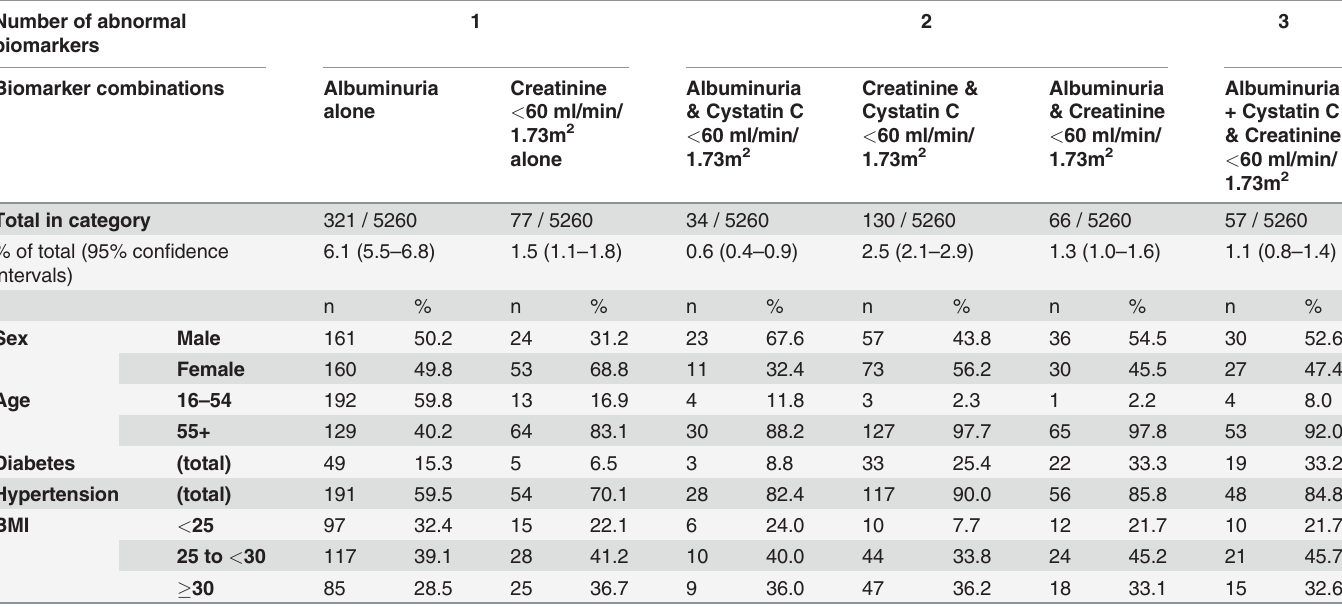
Table 3. Characteristics of populations with selected combinations of biomarkers following testing with cystatin C. Number of abnormal biomarkers Biomarker combinations